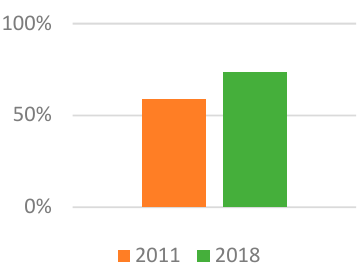
Figure 1. The prevalence of skin depigmenting ingredients in anti-aging products marketed in 2011 and 2018.